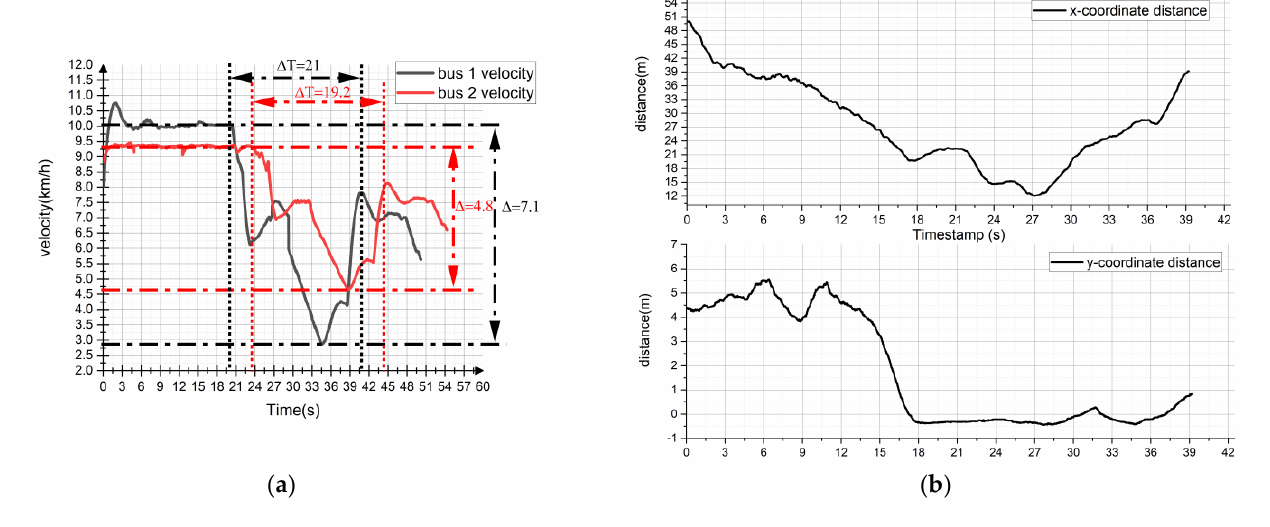
Figure 20. Automatic driving test field and test vehicle of Tianjin University.